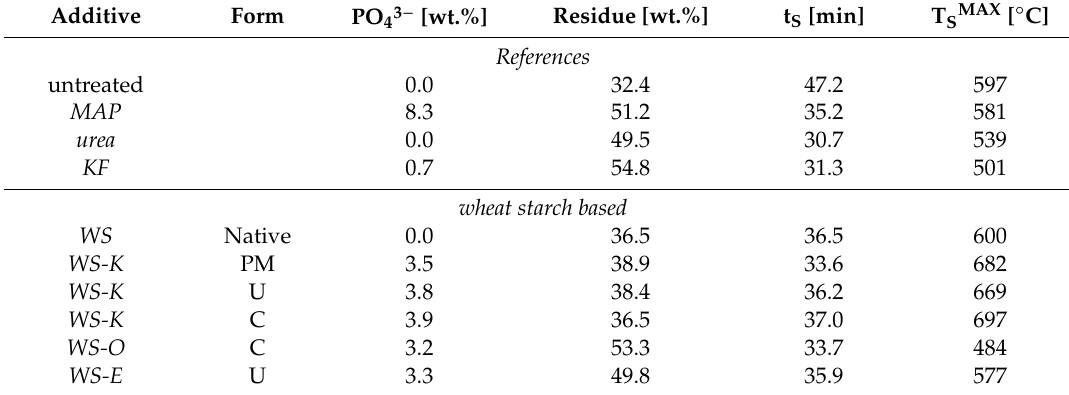
Table 3. Results of the smoldering tests.